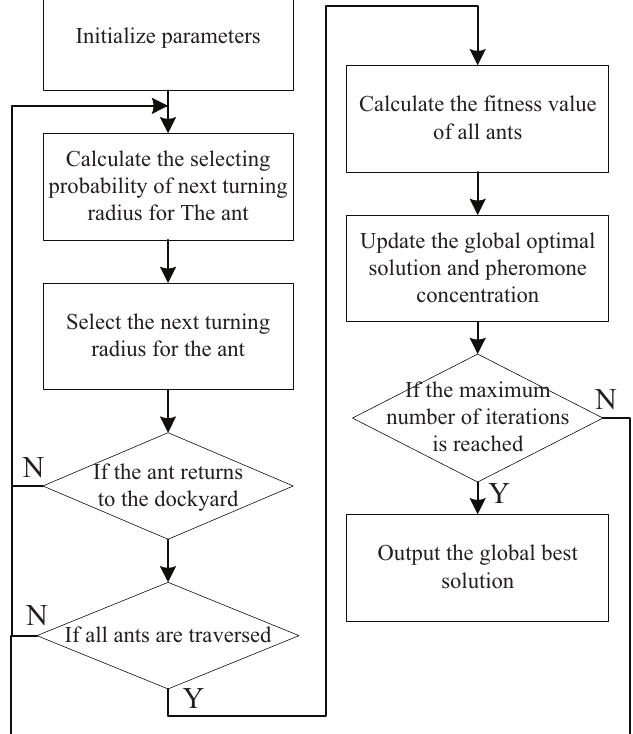
Figure 10. Main flowchart of ADTA-ACO.